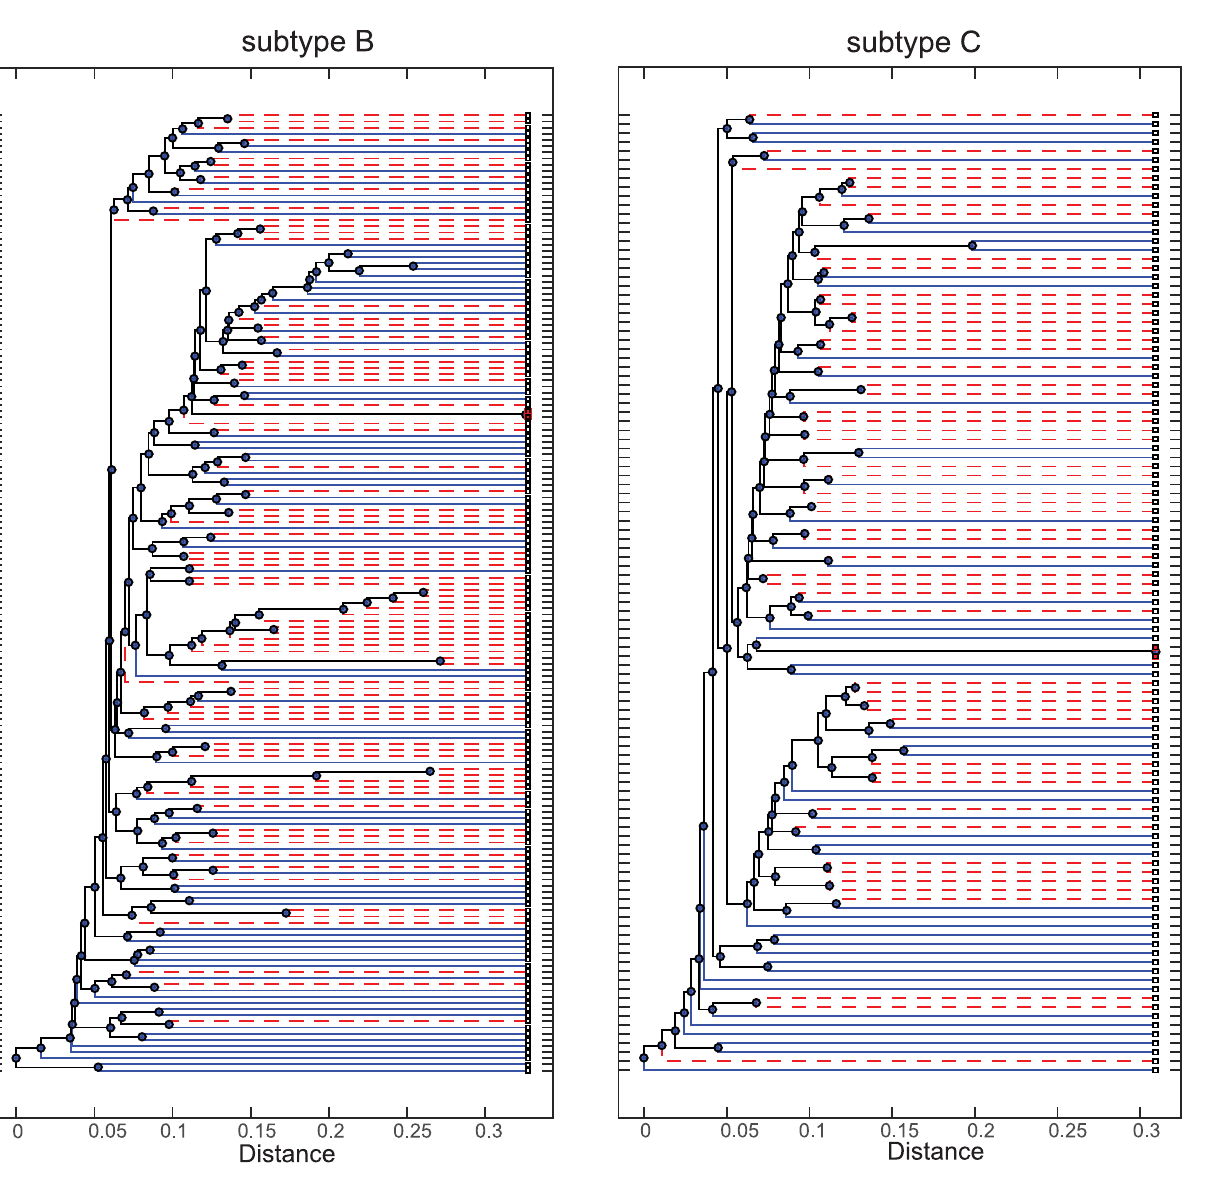
Fig 1. Unrooted phylogenetic trees for the subtype B and C HIV Env sequences. Founder sequencesare shown with red dashed branches,while chronicsequencesare denotedby blue branches.